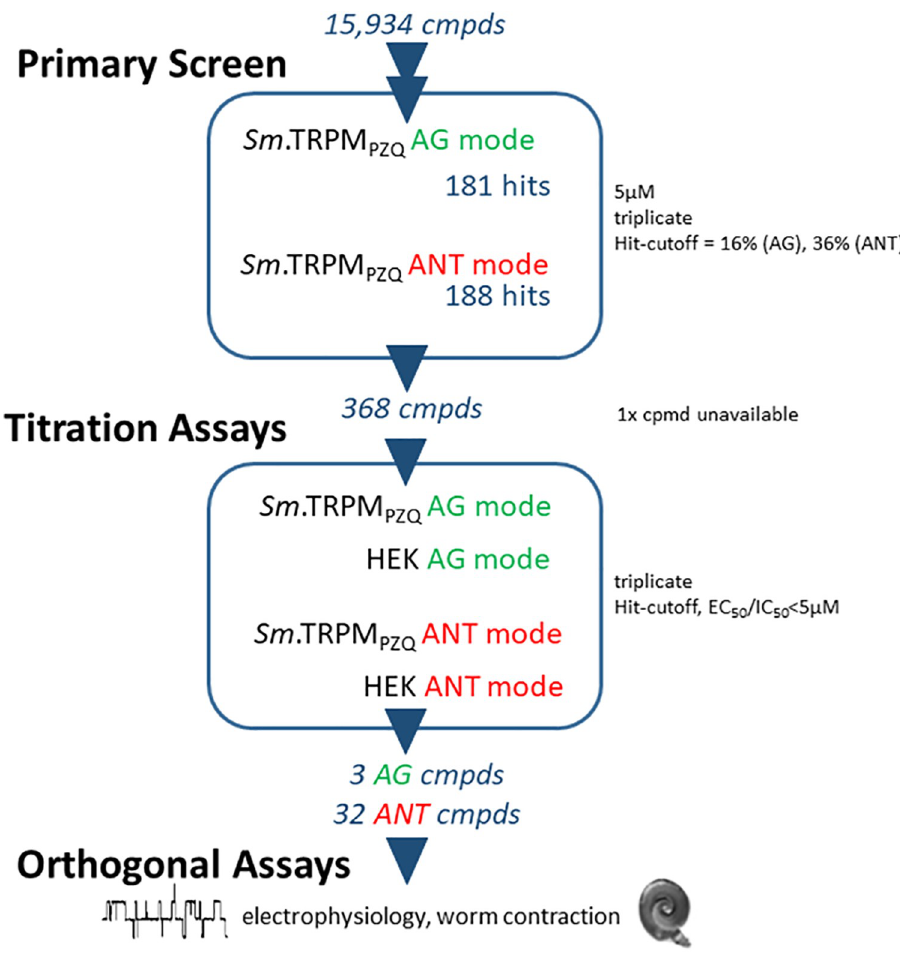
Fig 2. Sm .TRPM PZQ screening pipeline. All HTS assays were performed in 1,536 well format. A fixed concentration (nominally 5 μ M) primary screen was followed by titration assays and counter-screening in untransfected HEK cells. All assays were performed in triplicate in both agonist (AG) and antagonist (ANT) mode. From the original 15,934 compounds (cmpds) screened, the pipeline yielded 3 putative agonist ‘hits’ (two hits were identified as PZQ present as a ligand in the screened libraries) and 32 putative antagonist ‘hits’. Selected compounds were validated using electrophysiology and by monitoring contraction of schistosome worms ex vivo